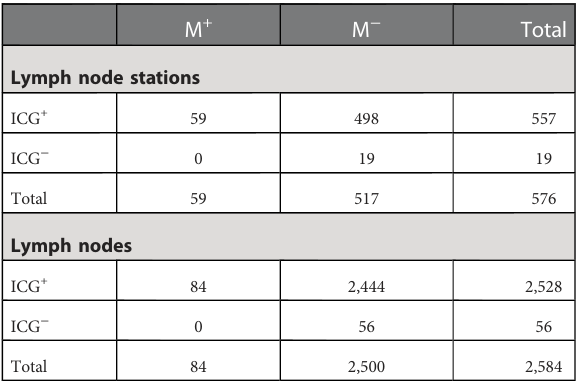
TABLE 2 Lymphadenectomy specimens according to fl uorescence and metastatic